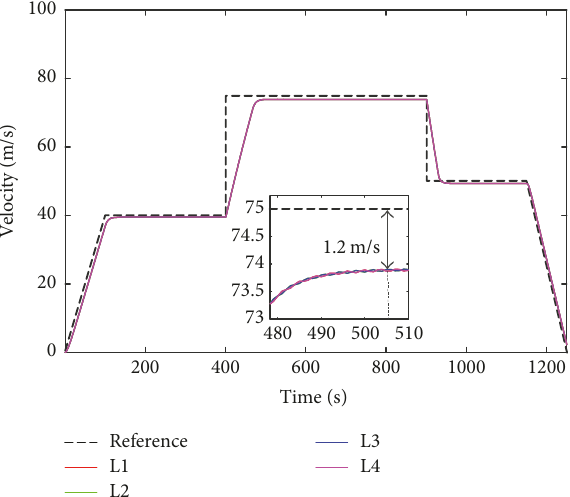
Figure 8: The velocity curve of each vehicle in Scenario